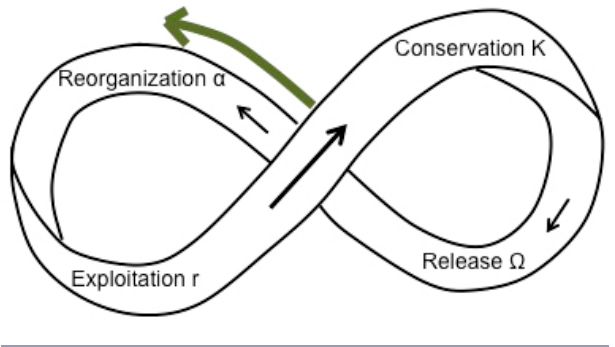
Fig. 4 . Overlay of employees of government and local organizations’ narrative onto the adaptive cycle. The employees of government and local organizations’ narrative of the local social-ecological system aligned with the early α phase after having collapsed from an agricultural landscape (collapse from K). The employees of government and local organizations’ narrative spanned a shorter period of time than that of the other informant groups.